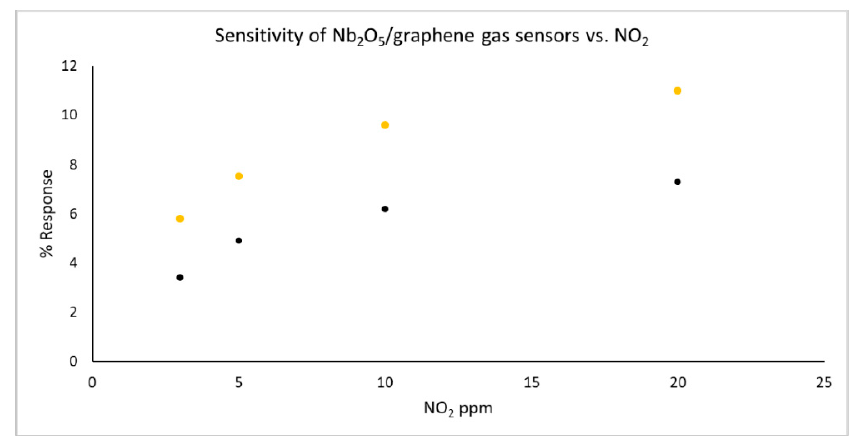
Figure 3. Sensitivity of Nb 2 O 5 /graphene sensors (yellow point = 80 W, dark points = 50 W) vs. NO 2 concentrations (RH% = 40%, T = 23